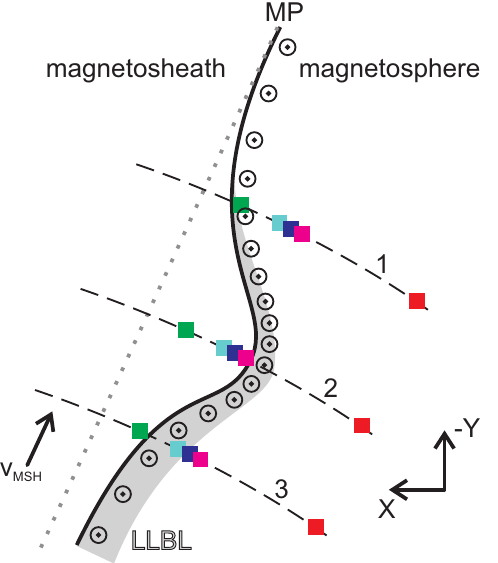
Fig. 8. A schematic drawing of the event 1. The order of THEMIS probes is: THB, THC, THD, THE and THA. The motion of the trough is represented by the motion of the THEMIS fleet in the op- posite direction. The location of the spacecraft prior to the event is denoted as 1 and after the event as 3. J represents the magnetic field orientation and its density and the shadowed area stands for an approximate thickness of the outer part of the